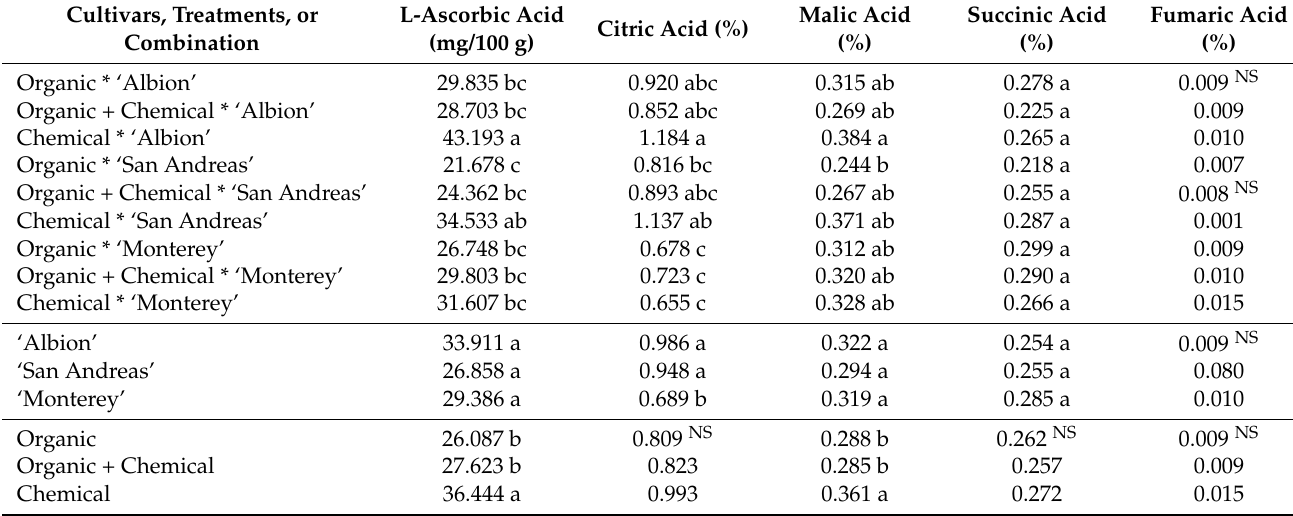
Table 4. The organic acid content of strawberry fruits is affected by different fertilizer